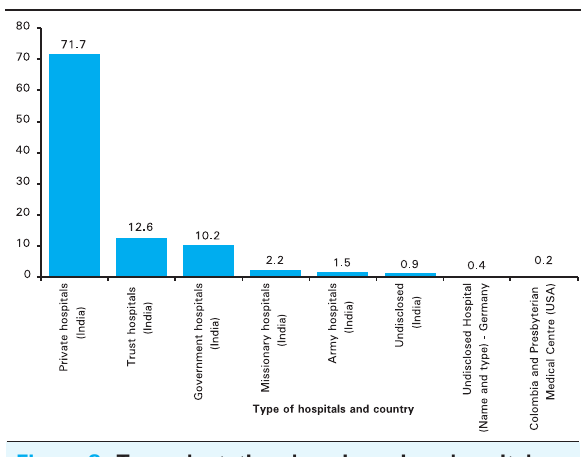
Figure 2. Transplantation done in various hospitals